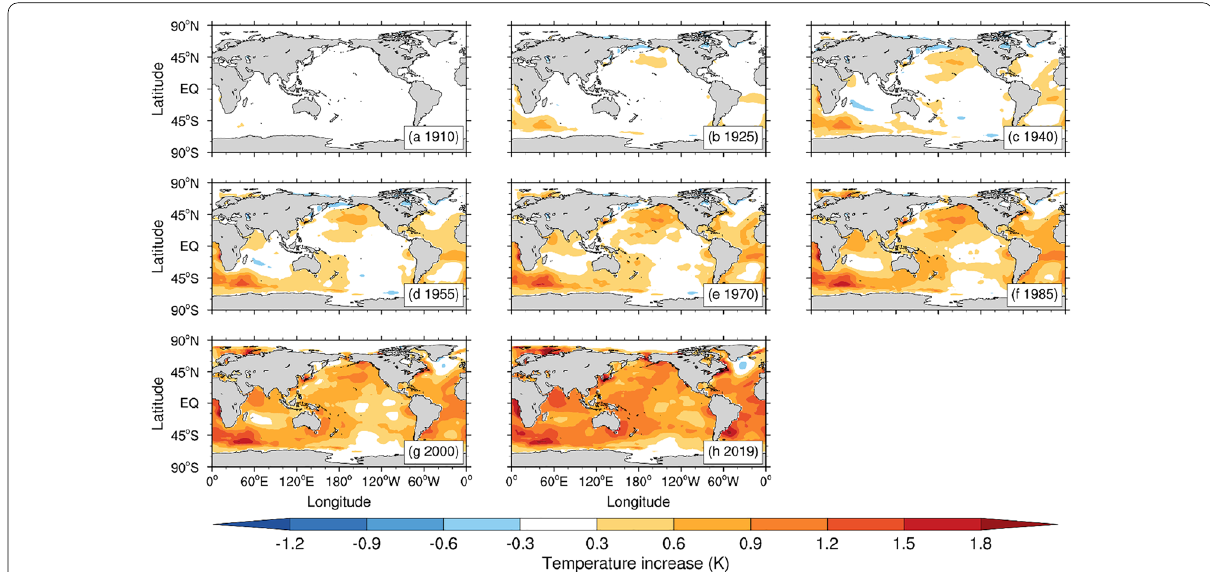
Fig. 4 Spatial evolution of the intrinsic trends of global sea surface temperature derived from a quadratic fitting. (a–h) The intrinsic trends ending in 1910, 1925, 1940, 1955, 1970, 1985, 2000, and 2019,